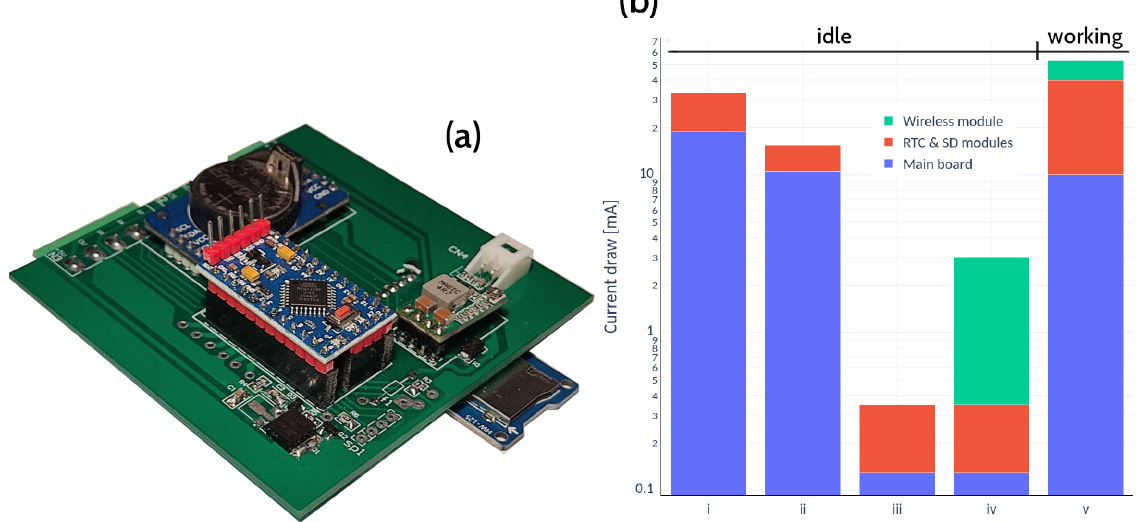
Figure 3. ( a ) The PCB with the datalogger components mounted (the microcontroller, the storage unit and the real-time clock); ( b ) successive trials leading to the final energy-saving scheme: (i) Arduino Pro Mini with SD and RTC modules ( ≈ 33 mA), (ii) case (i) in sleep mode ( ≈ 11 mA), (iii) power gating technique with no LED after (ii) ( ≈ 0.35 mA), (iv) with wireless module added to (iii) ( ≈ 3 mA), (v) average power consumption of about 53 mA in full working mode, i.e., with sensor reading, storing data and